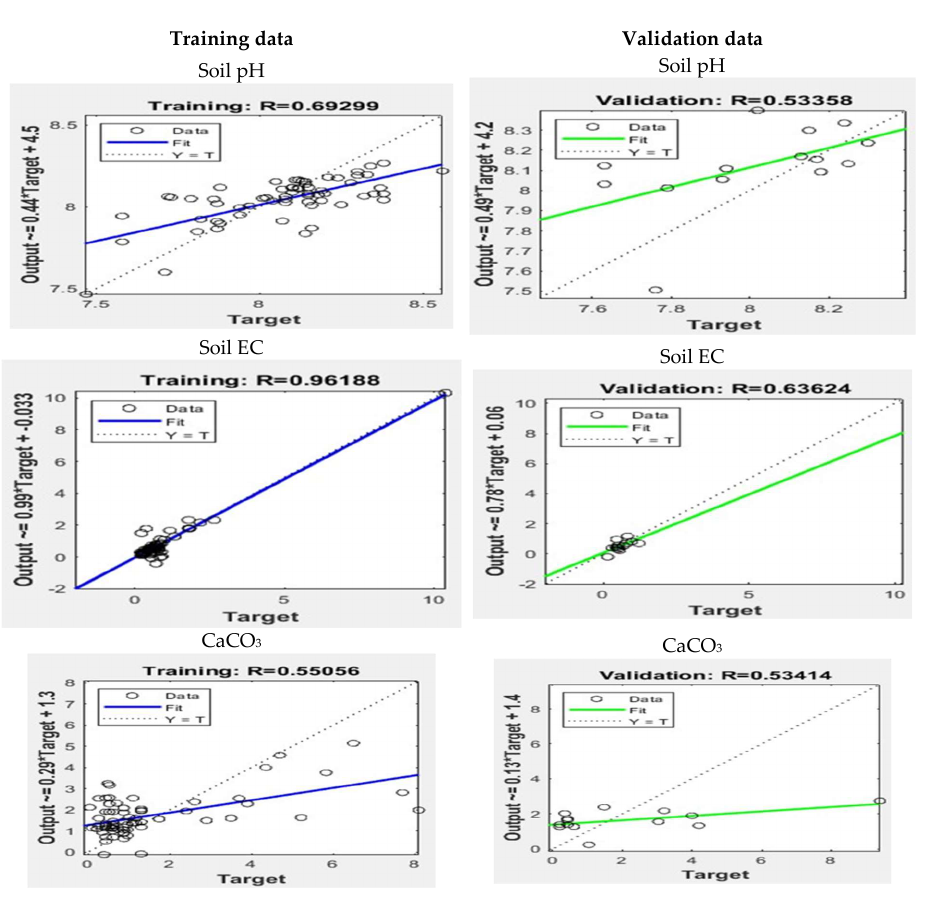
Figure 9. ANN training/calibration and validation of soil parameters.